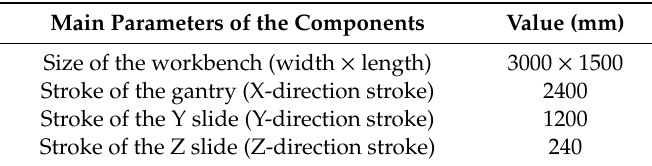
Table 1. Size of main components.